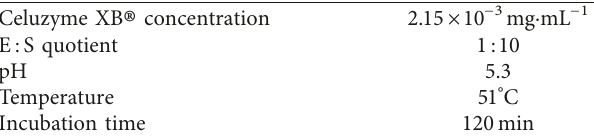
Table 1: Determined chemical conditions for the enzymatic depolimerization. Celuzyme XB ® concentration